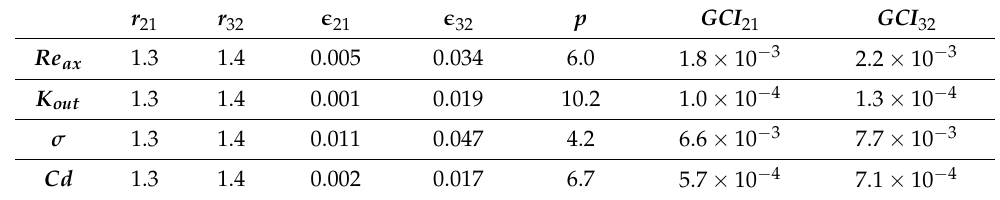
Table 2. Grid Convergence Index for the most important dimensionless OAS